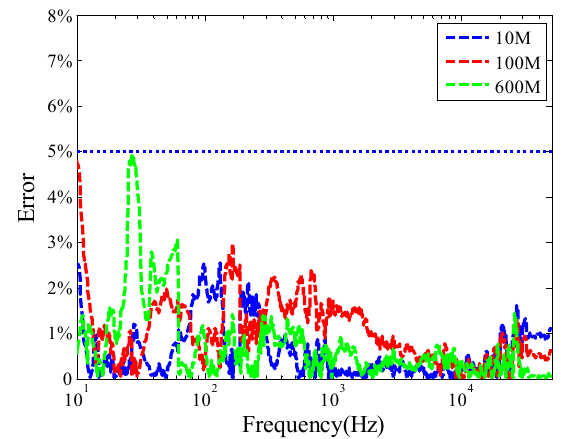
Electronics 2019 , 8 , x FOR PEER REVIEW Figure 4. The error between the phase noise restored and measured. Figure 4. The error between the phase noise restored and measured. Figure 4. The error between the phase noise restored and measured.